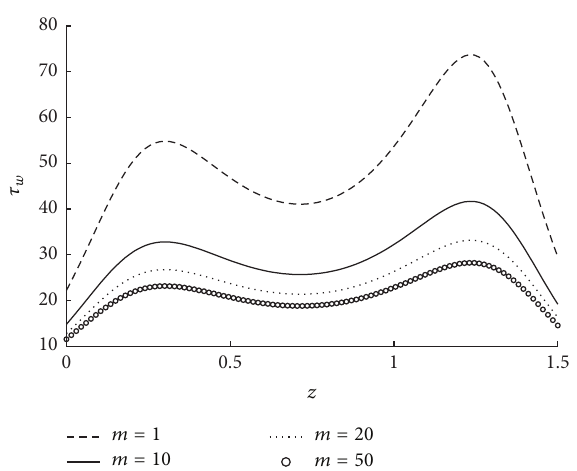
Figure 14: The variation of shear stress at wall in stenosed region with respect to 𝑚 when 𝑟 𝑐 = 0.1 , 𝑢 = 0.01 , 𝜖 = 0.1 , 𝑁 = 0.75 , and 𝜙 = −0.05 .